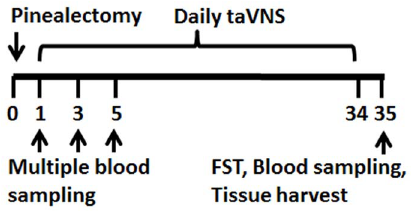
Figure 1. Illustration of experimental time in days. Showing time points for pinealectomy operation, taVNS, blood sampling, FST, and tissue harvest. Pinealectomy operation was done on day 0 (before taVNS sessions). Once daily taVNS administration began on day 1 and continued to day 34. Multiple blood sampling happened on day 1, 3, and 5 of taVNS sessions. On day 35, FST, blood and tissue sampling were done.